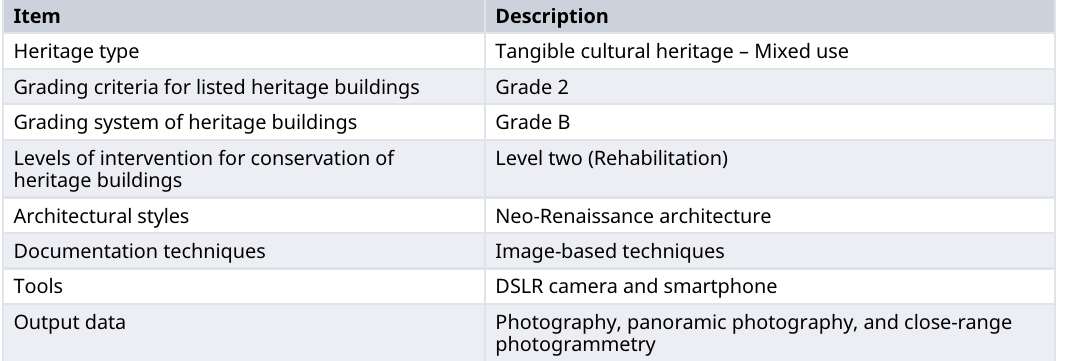
Table 2. Documentation phase for the Société Immobilière